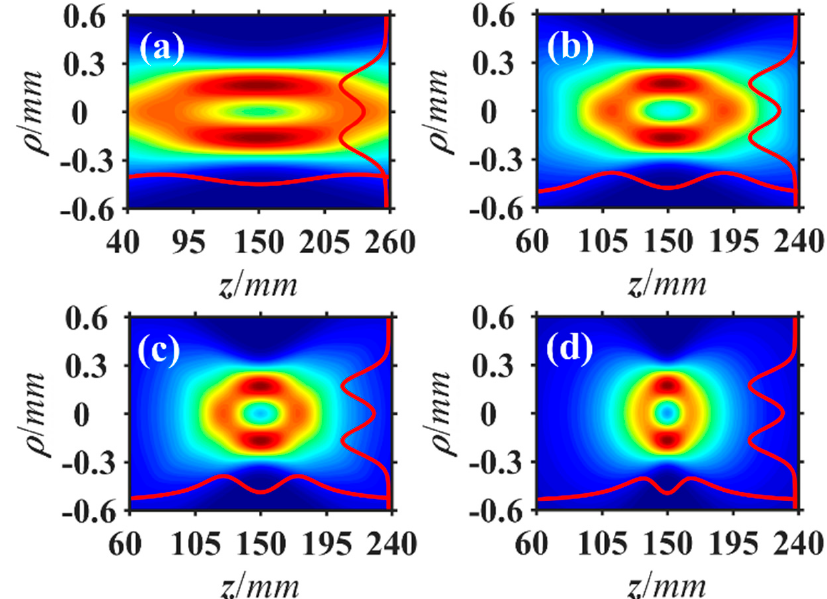
Figure 1. Normalized intensity distribution of an apertured Bessel–Gaussian correlated Schell-model (BGCSM) beam focused by a thin lens in the ρ – z plane for different values of aperture radius a , with δ 0 = 0.2 mm and β = 2.5. ( a ) a = 0.5 mm; ( b ) a = 1 mm; ( c ) a = 1.5 mm; and ( d ) without aperture.